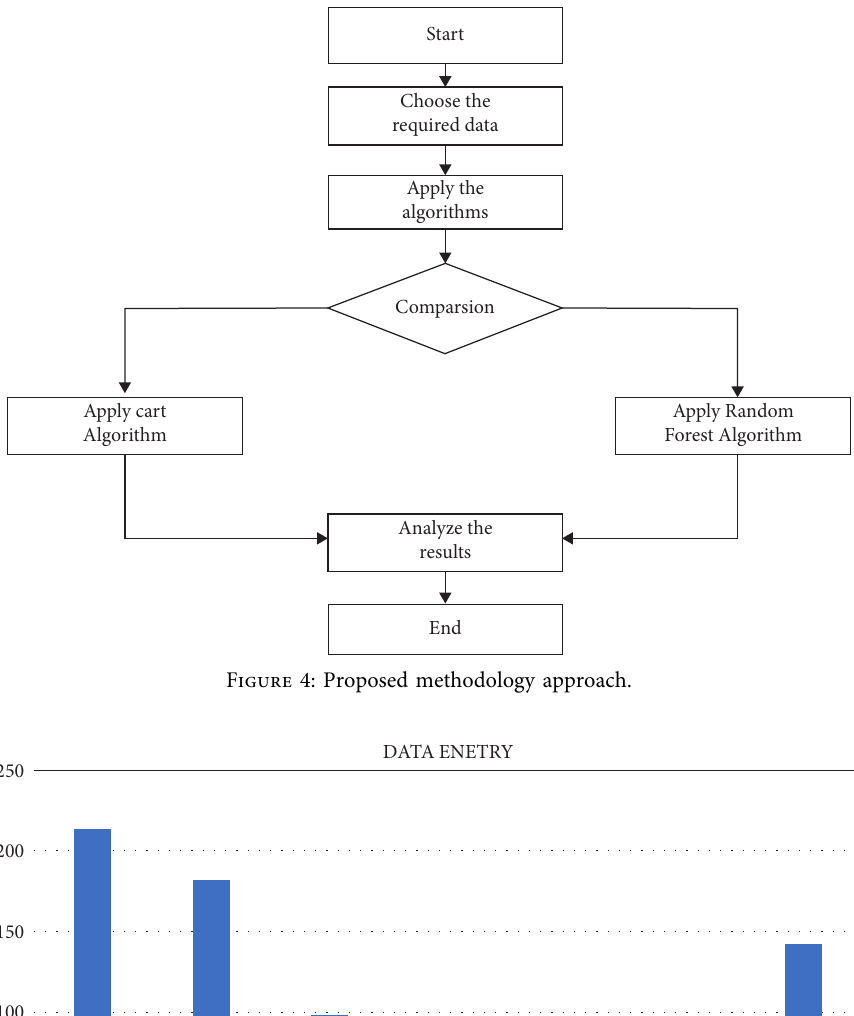
Figure 5: Survey details of